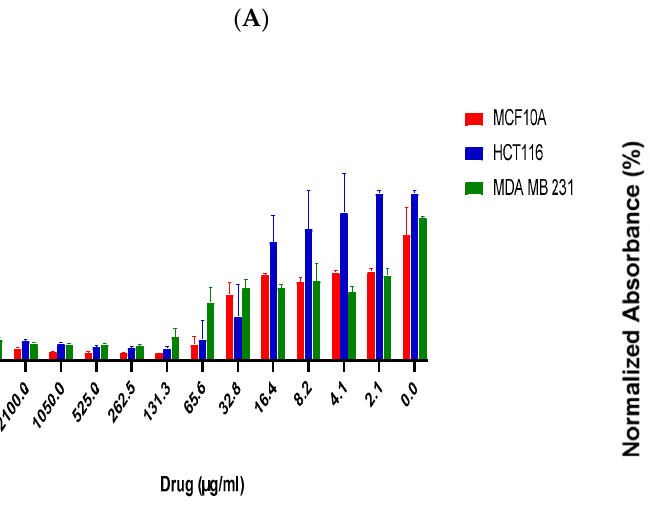
Figure 11. Effect of L- AgNPs on the cell viability of normal and cancer cells. Bar graph showing dose relationship of L-AgNPs on the viability of two human cancer cell lines; HCT116 ( ) and MDA-MB-231 ( ) and a normal cell line; MCF 10A ( ) ( A ). Log dose-response relationship of L-AgNPs on the normalised viability of two human cancer cell lines; HCT116 ( ) and MDA-MB-231 ( ) and one normal cell line MCF 10A ( ) ( B ). IC 50 values of AgNPs on each cell line was calculated using Log viability vs. normalised response − variable slope (four-parameter).